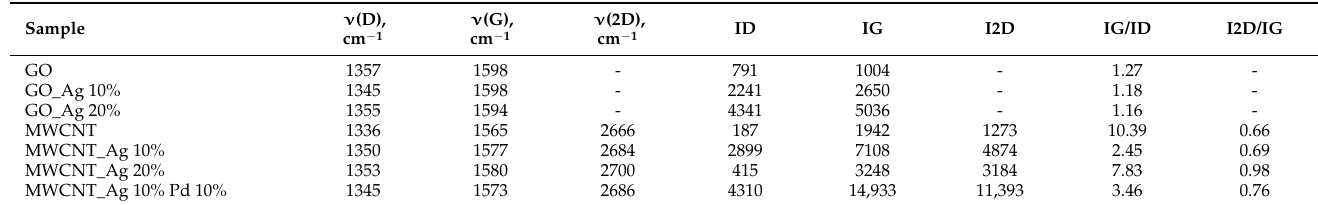
Table 2. Results of the Raman spectra of the synthesized catalysts and initial carbon supports.